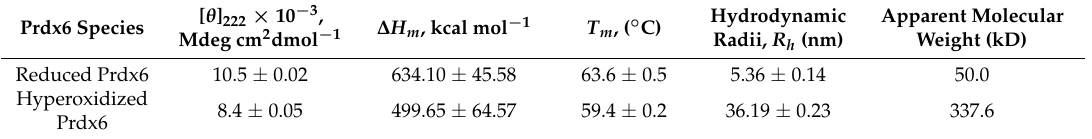
Table 1. Conformational and thermodynamic parameters of reduced and hyperoxidized Prdx6. Prdx6